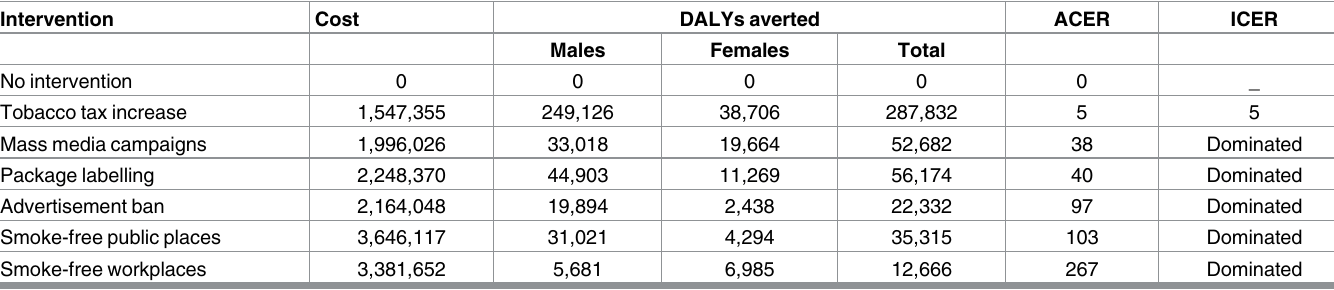
Table 8. Cost, effectiveness and cost-effectivenessfor base-casetobacco control strategies in